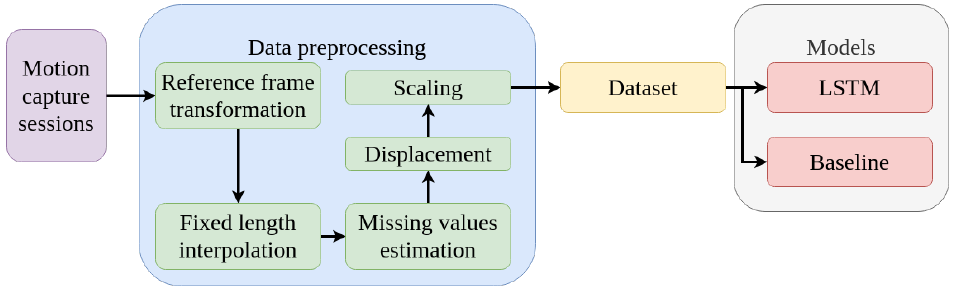
Figure 1. The pipeline’s